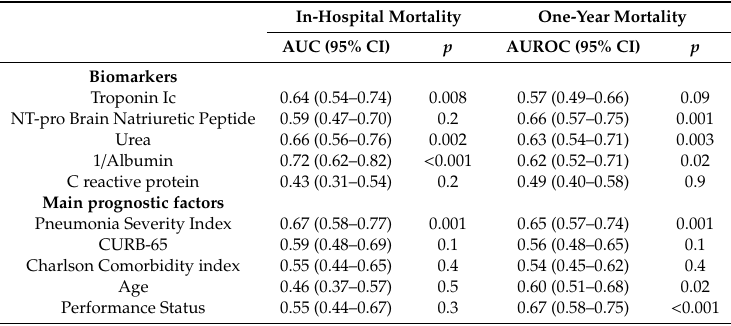
Table 5. Area Under the Receiver Operating Characteristic Curve (AUC) for in-hospital mortality and one-year mortality comparing the main prognostic factors after acute